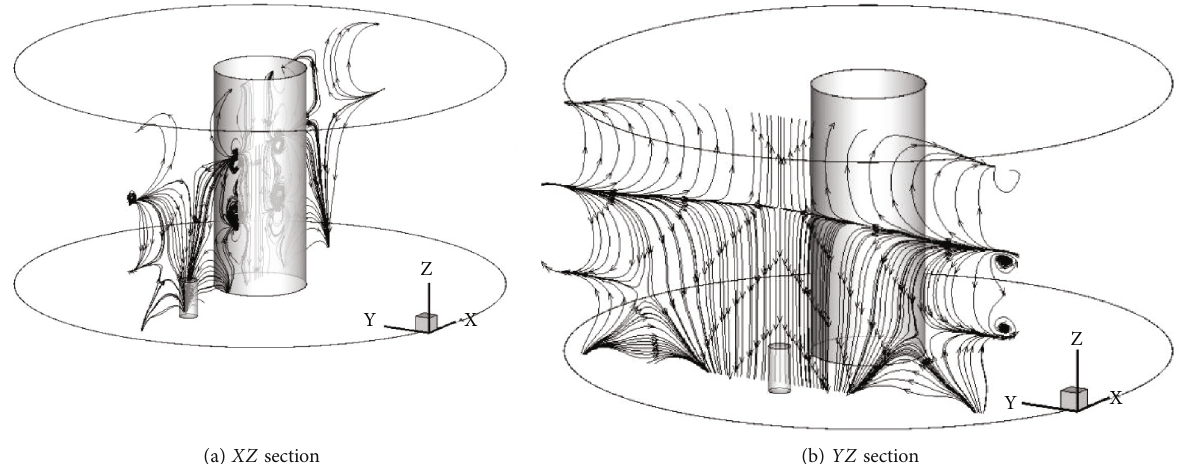
Figure 25: Di ff erent sections of 3D view of magnetic fi eld line near cathode.